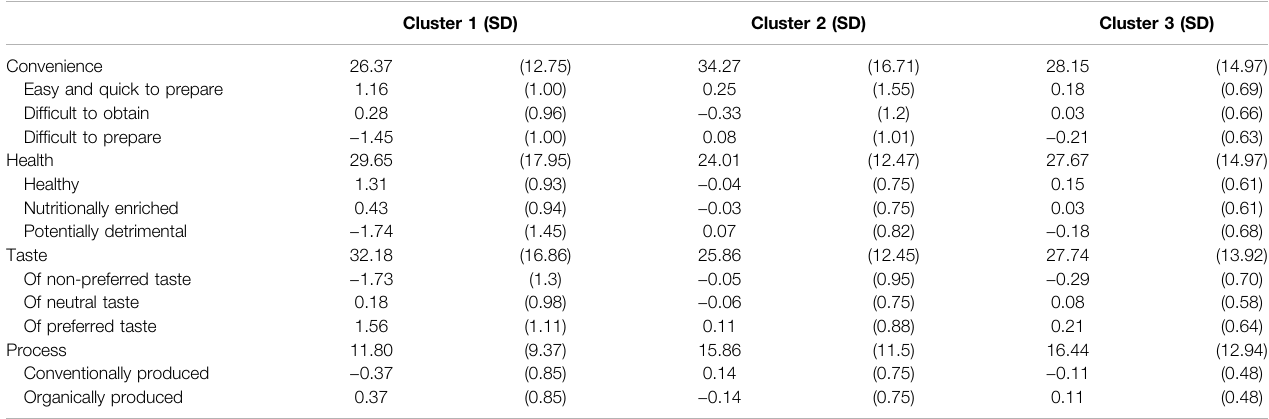
TABLE 3 | Cluster mean values for product quality attributes.